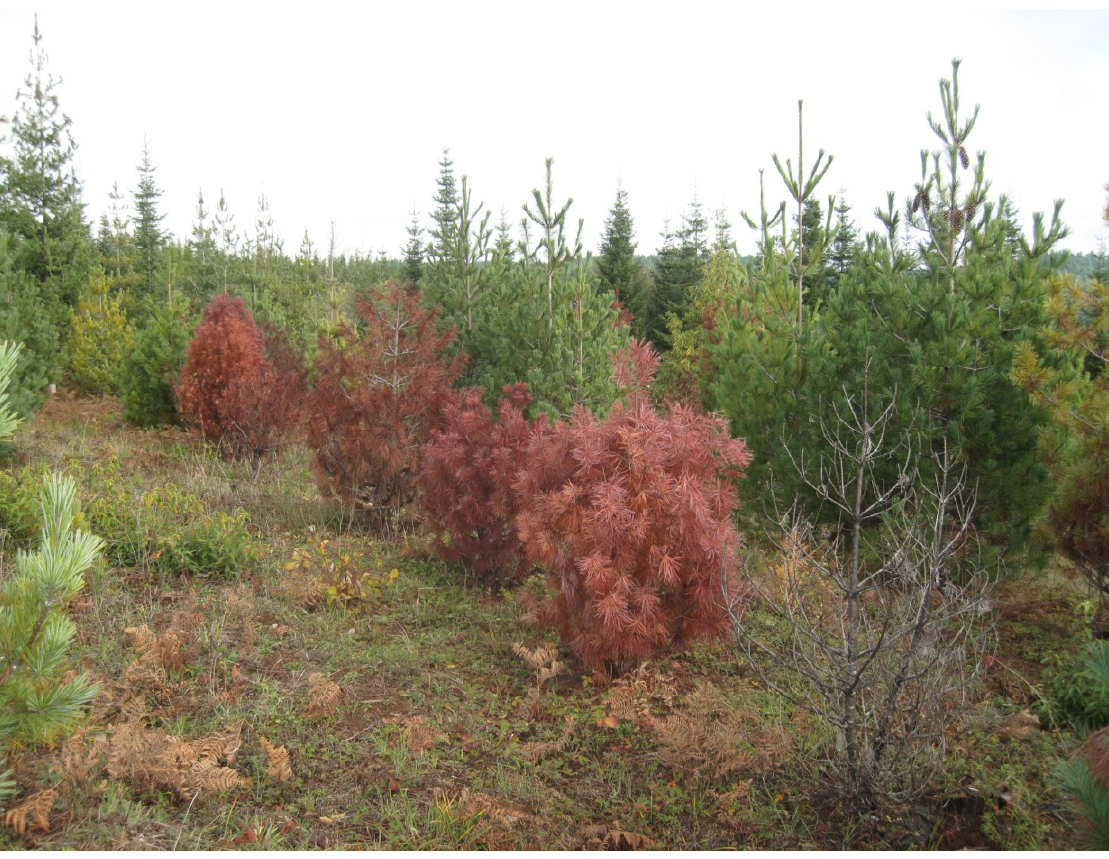
Figure 7. Western white pine families in a field trial in western Oregon, where blister rust genotypes with the vcr2 gene that overcomes the HR resistance are present (November 2012). The dead trees are from an open-pollinated orchard seedlot from a parent tree homozygous dominant for the complete (HR) resistance conditioned by the Cr2 gene ( Cr2Cr2 × wind). At this site, families with only Cr2 gene for resistance show 95 percent or greater stem infection, similar to the susceptible control family, while many of the families with partial resistance do significantly better (adjacent living trees shown in this